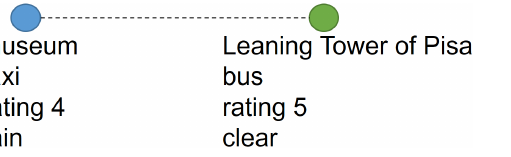
Figure 2. Example of a trajectory query with information on stops and aspects.